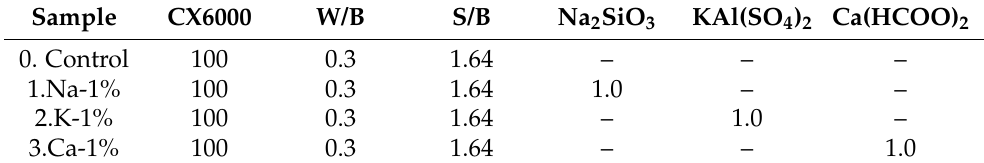
Table 1. Ultrafine cement (CX6000) with hardening accelerators mortar mix ratio.